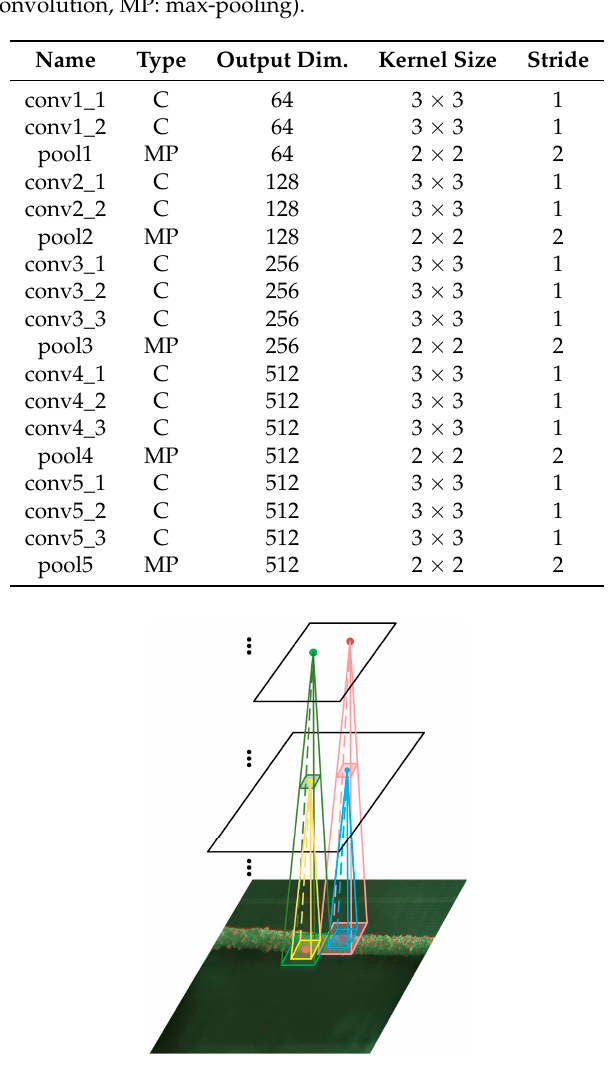
Figure 2. Illustration of corresponding mapping location of keypoint in different layers.